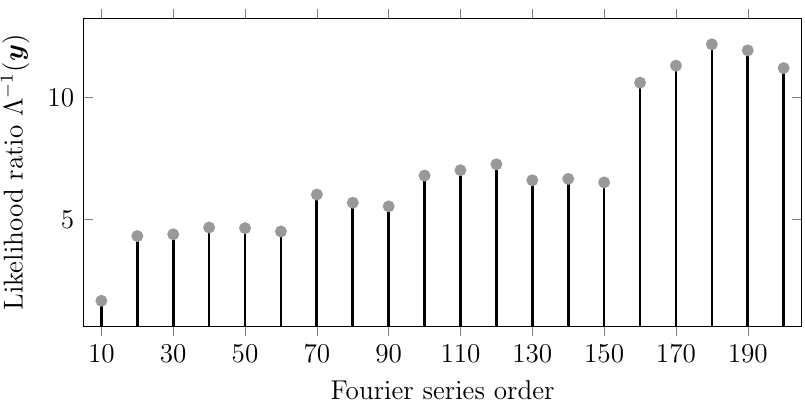
Figure 9. Generalized likelihood ratio (GLR) for Example 10 (polynomial model). The vertical axis values represent the likelihood ratio, and the horizontal axis represents the polynomial order used for generating the H ( i ) matrix.